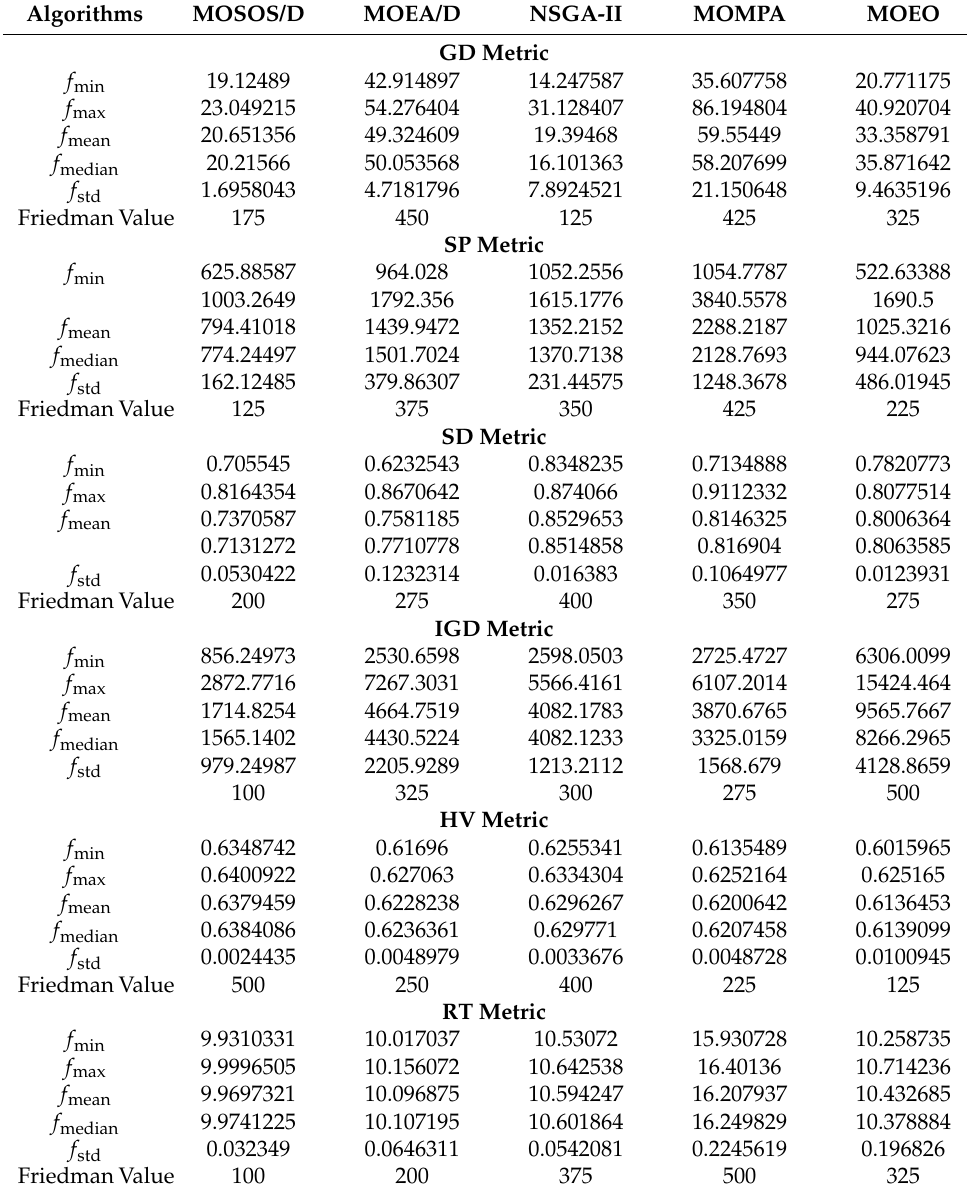
Table 8. The results of different metrices for the 10-bar truss bar